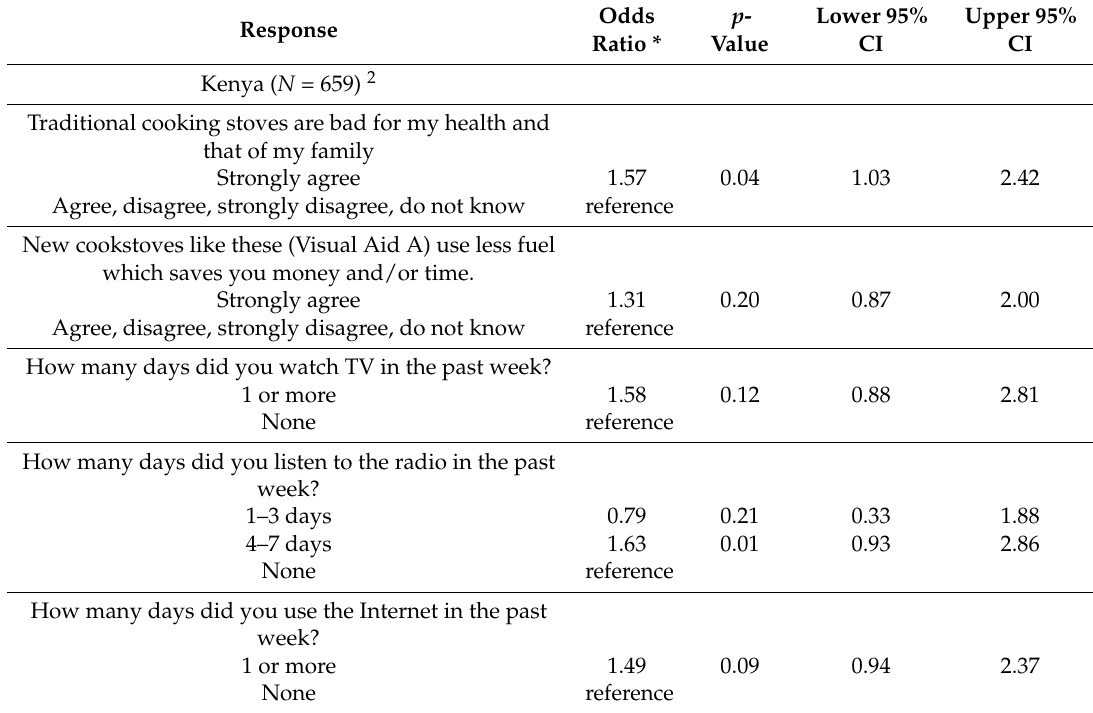
Table 6. Results from multivariable logistic regression. OUTCOME 1: Intention to buy a modern stove (or LPG stove in Nigeria) 1